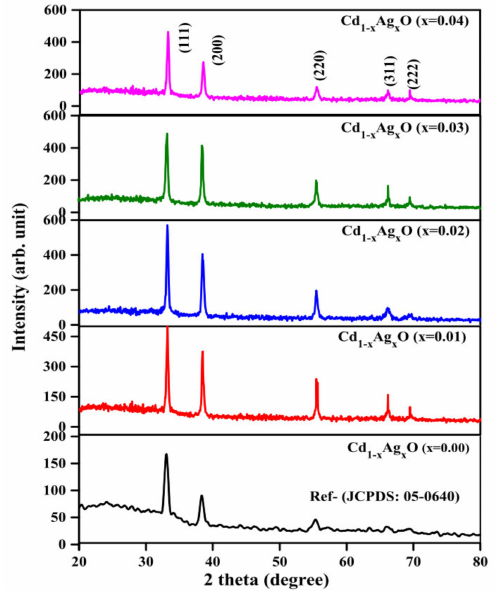
Figure 1. XRD patterns of Ag-doped CdO thin films with different Ag doping